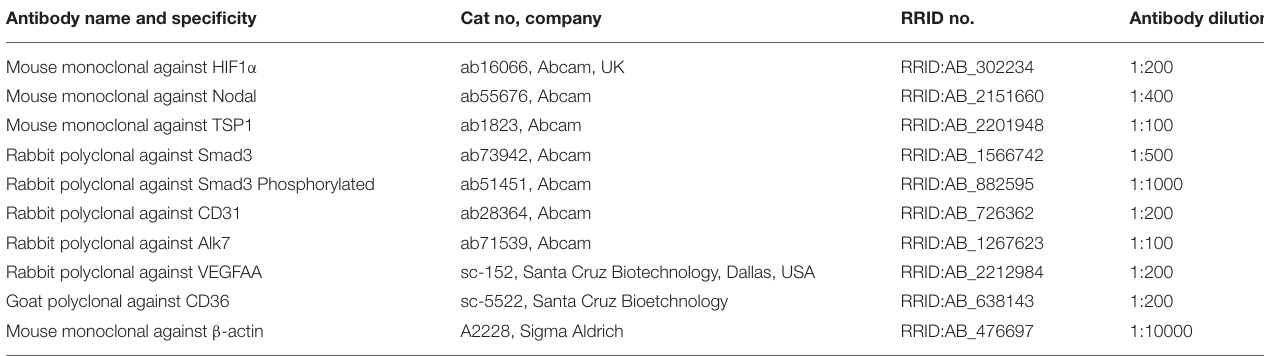
TABLE 2 | Specification of antibodies used for western